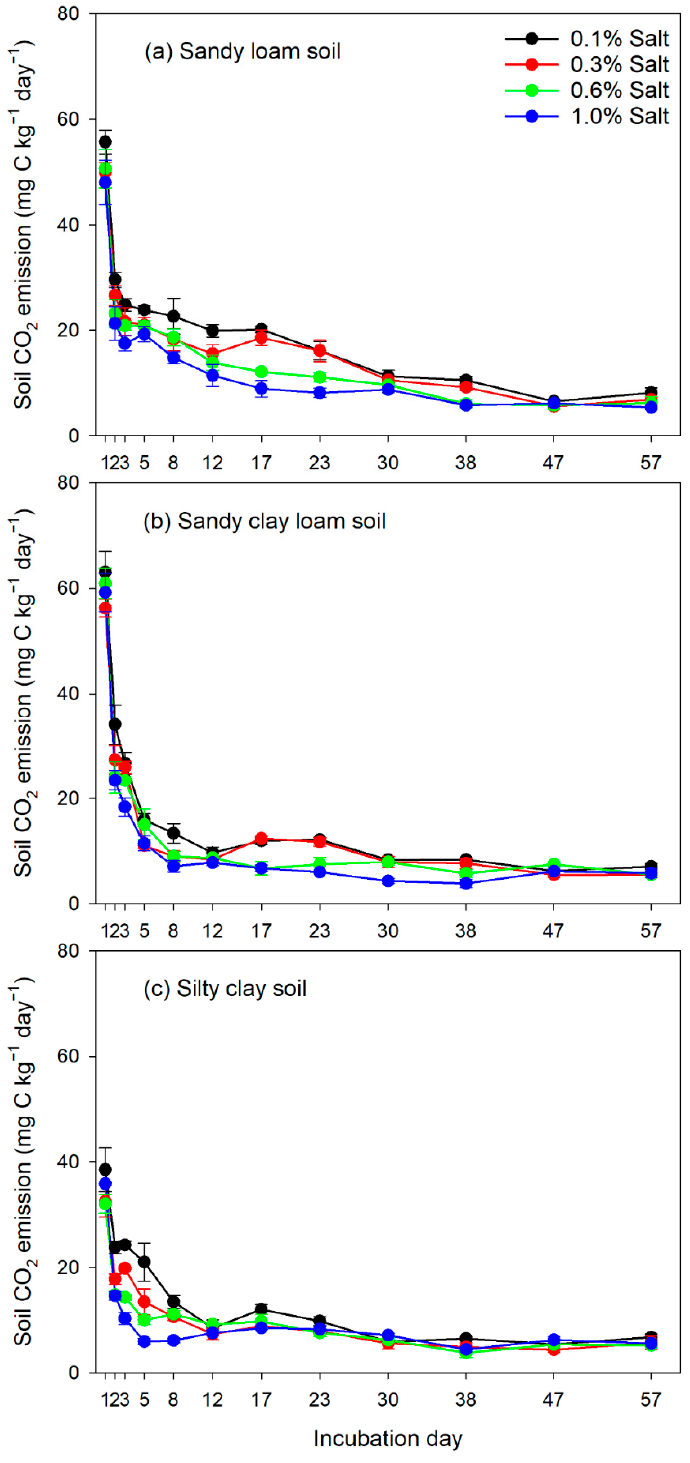
Figure 1. Soil CO 2 emissions from the sandy loam soil ( a ), sandy clay loam soil ( b ) and silty clay soil ( c ) at different salt levels. Error bars indicate the standard error of the mean ( n =